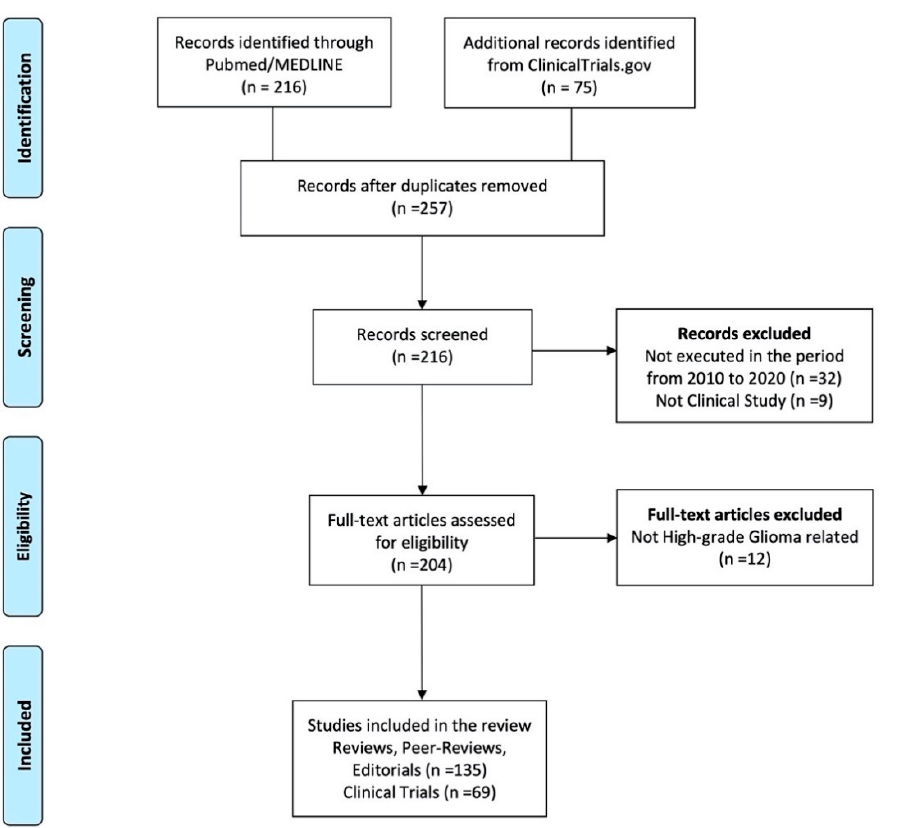
Figure 1. PRISMA (Preferred Reporting Items for Systematic Reviews and Meta-Analysis) flow-chart.